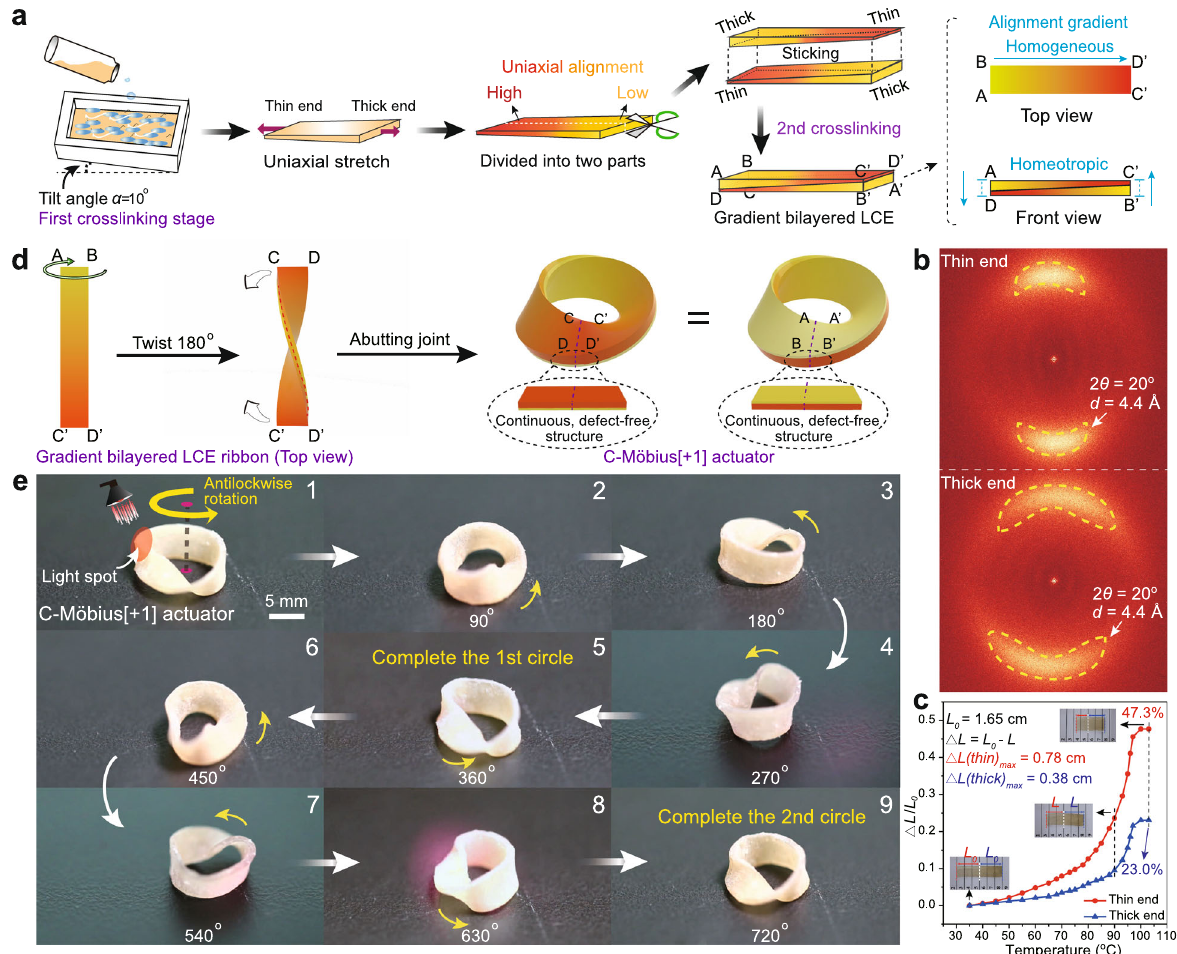
Fig. 5 Photoguided in situ continuous rotation of the C-Möbius[ + 1] actuator. a Schematic illustration of the preparation procedure of the bilayered LCE ribbon with a homogeneous and homeotropic mesogen alignment gradient. The colour gradient from red to yellow represents the uniaxial alignment gradient (the red part indicates high uniaxial alignment, and the yellow part indicates low uniaxial alignment, same as in ( d )). b 2D WAXS patterns of the thin and thick ends of the LCE fi lm. c Photothermal shrinkage ratios of the thin and thick ends of the LCE fi lm during the heating process. d Schematic illustration of the fabrication procedure of the C-Möbius[ + 1] strip actuator with a homogeneous and homeotropic alignment gradient. e Photographs of the continuous anticlockwise rotation of the C-Möbius[ + 1] strip actuator under irradiation with NIR light (scale bar: 5 mm). Supplementary Movie 10 shows the scenario in